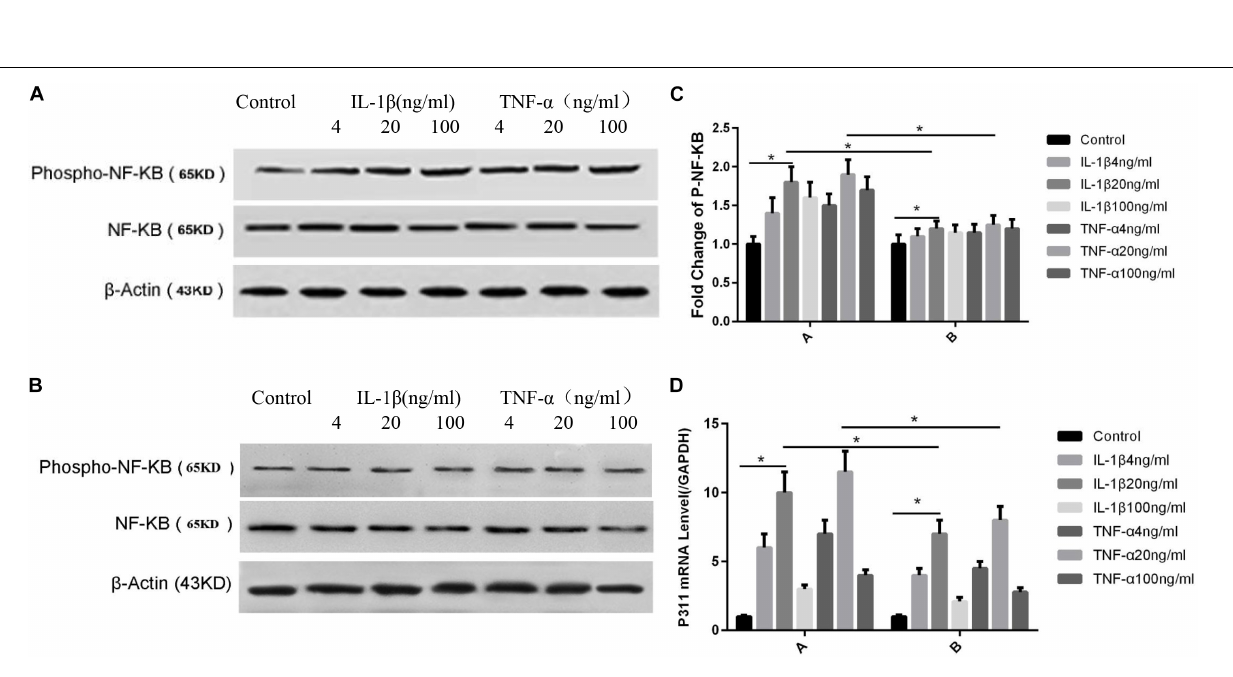
Frontiers in Physiology |